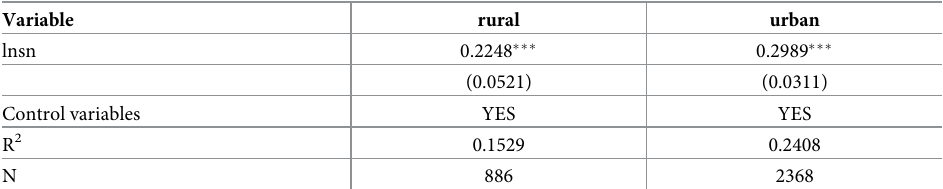
Table 8. Estimated results of the urban–rural differentiation.